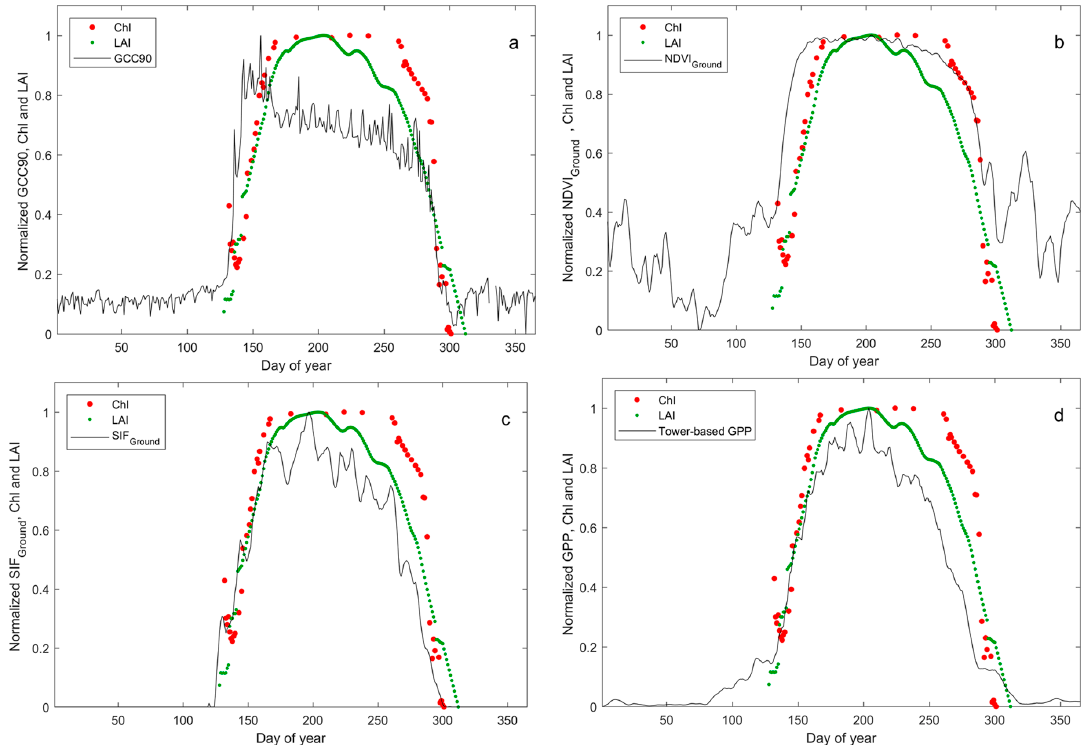
Figure 3. Comparison of physiological properties including leaf area index (LAI) and leaf chlorophyll content (Chl) versus the 90th percentile of the green chromatic coordinates (GCC90) ( a ), ground-based NDVI (NDVI Ground ) ( b ), ground-based SIF (SIF Ground ) ( c ) and tower-based GPP ( d ) at Harvard Forest in 2014. All the time series are normalized and have a daily time step.